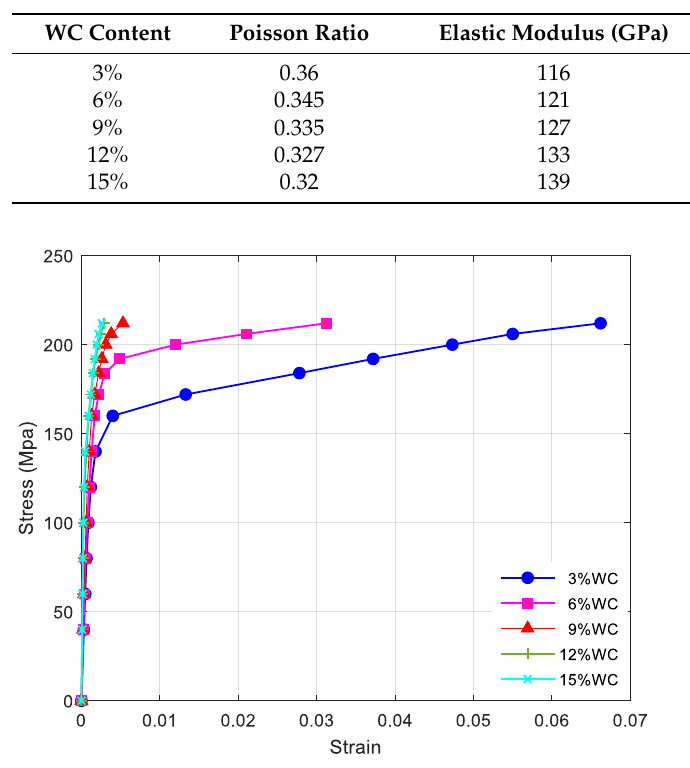
Figure 5. Stress – strain curves of Cu/WC P composites under different volume content. Figure 5. Stress–strain curves of Cu/WC P composites under different volume